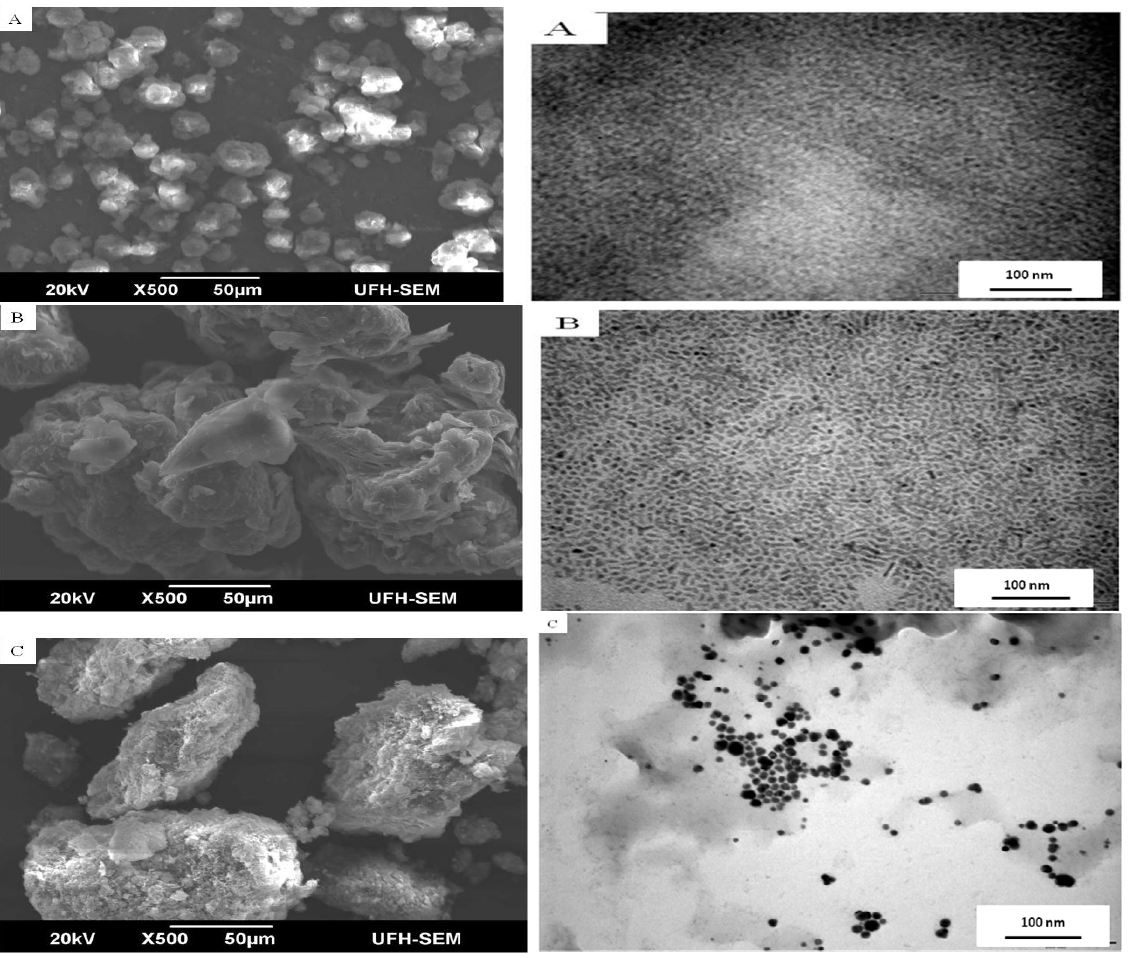
Figure 2. SEM/TEM images of ZnS ( A ), CdS ( B ) and HgS ( C )